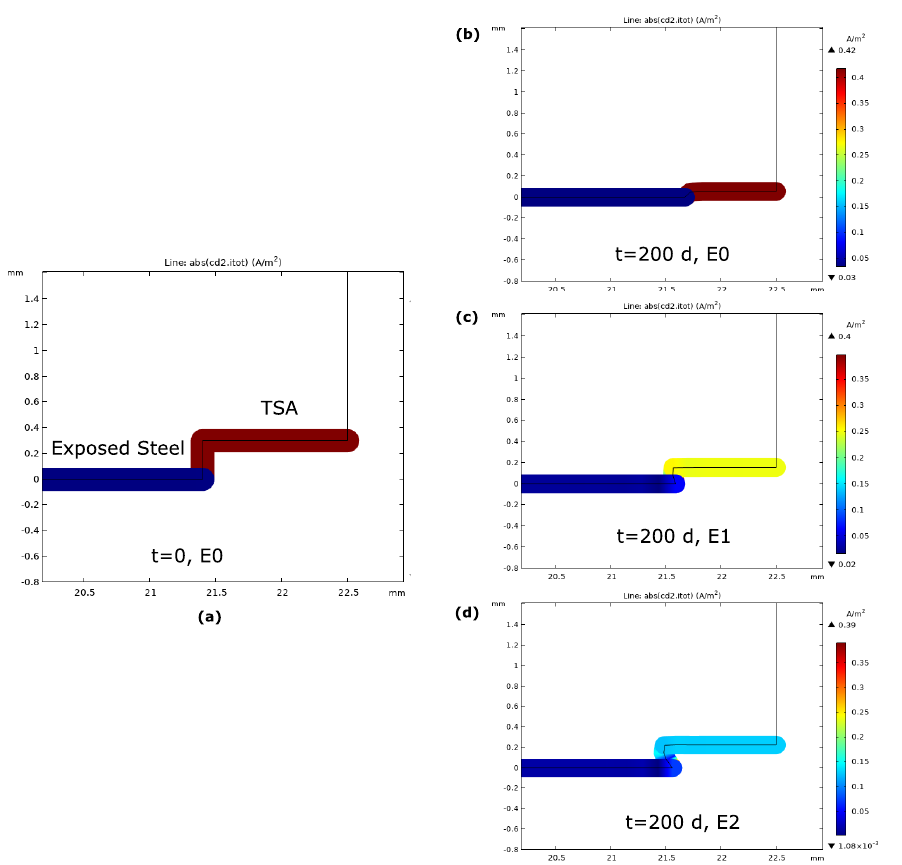
Figure 5. (ALE) Mesh moving technique and current density of TSA coating with 90% of exposed steel. Notice that only a representative part of the cathode of the entire geometry is shown. ( a ) t = 0 and initial condition E0 . ( b ) t = 200 d and initial condition E0 . ( c ) t = 200 d and condition E1 . ( d ) t = 200 d and condition E2 .